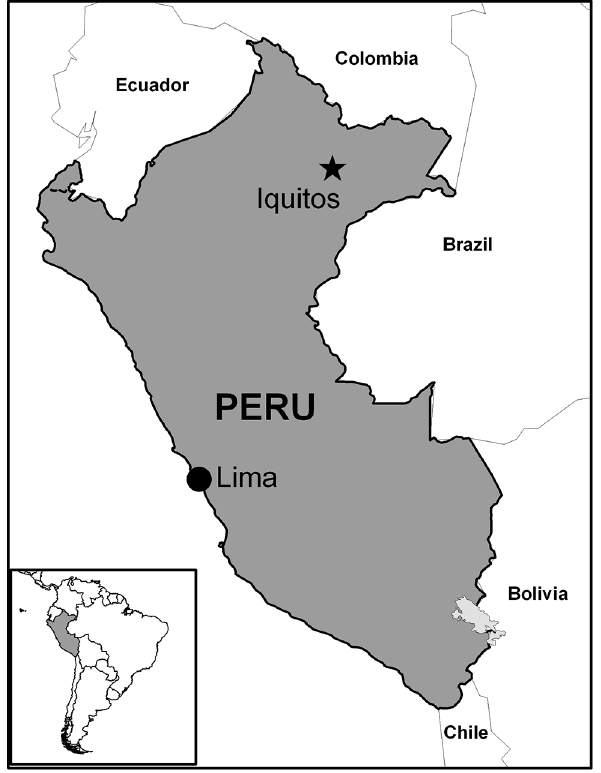
Fig 1. Map of Peru indicating the study site of Iquitos in the Peruvian Amazon Basin and the capital Lima, site of the main U.S. Medical Research Unit No. 6